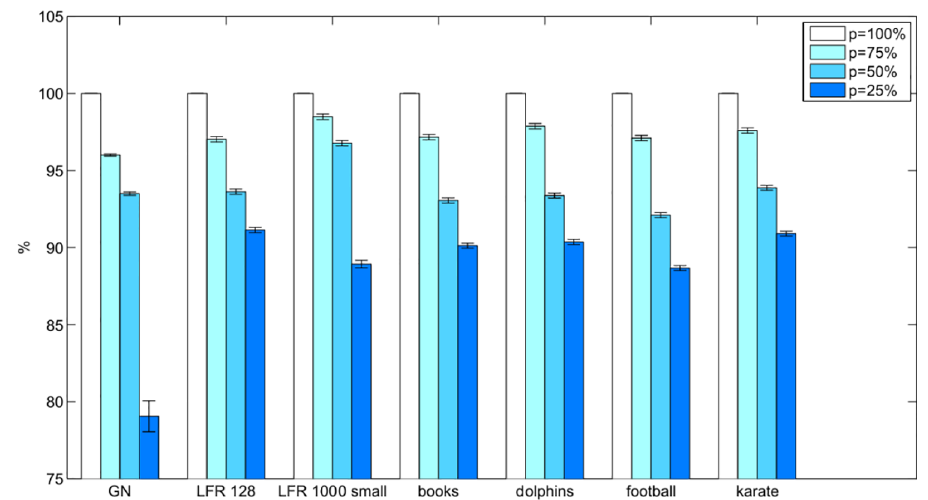
Fig 12. Differencesin running times for the four tested p values as percentage of the running time for the p = 100% casefor each network set.